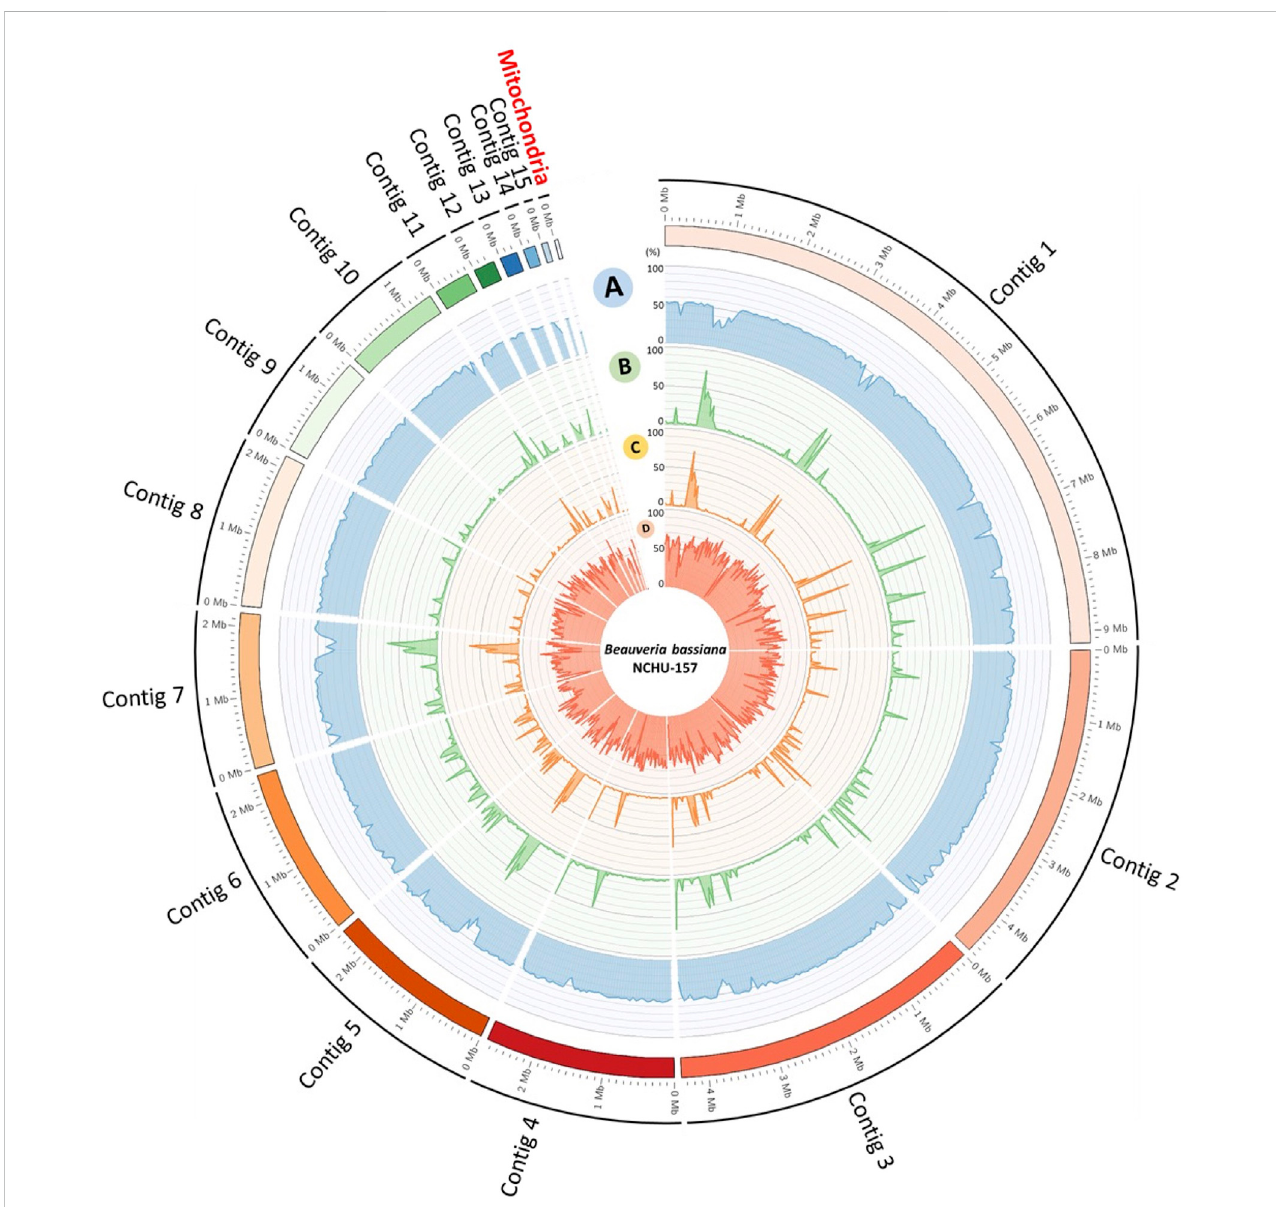
FIGURE 1 Wholegenomemapof fi fteencore chromosomes plusone mitochondrial genomeofBb-NCHU-157. (A) GC%, (B) repeatdensity, (C) TEdensity,and (D) gene density. All skew CIRCOS maps were drawn with a 50 kbp